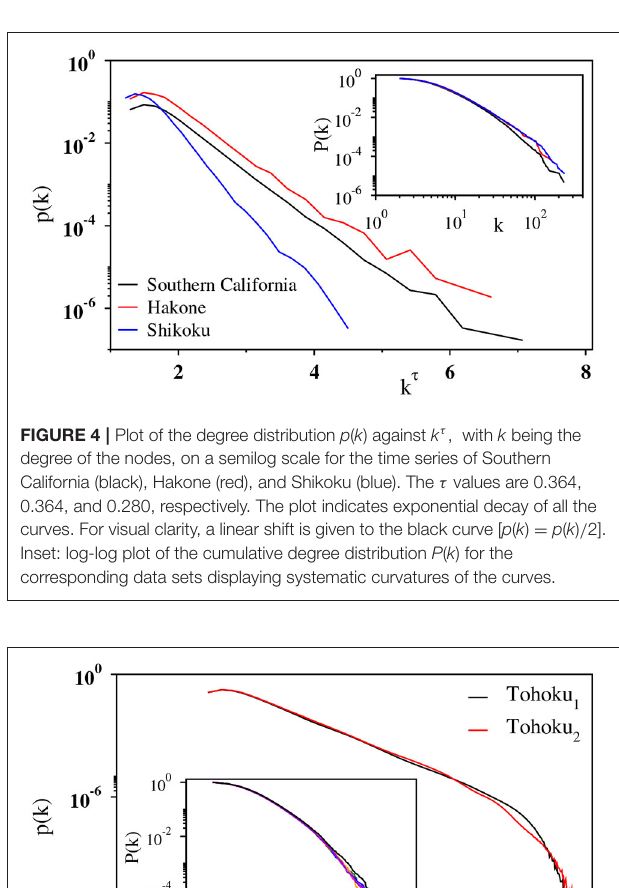
FIGURE 5 | Main panel: Semilog plot of the degree distribution, p ( k ) vs. k τ , with k being the degree of the nodes, for the shuffled series corresponding to Tohoku 1 (black) and Tohoku 2 (red). The plot is based on 10 6 independent shuffled series. Inset: Log-log plot of the cumulative degree distribution P ( k ) for six individual shuffled series of Tohoku 1 (different colors are used to represent different shuffled series) along with the original one